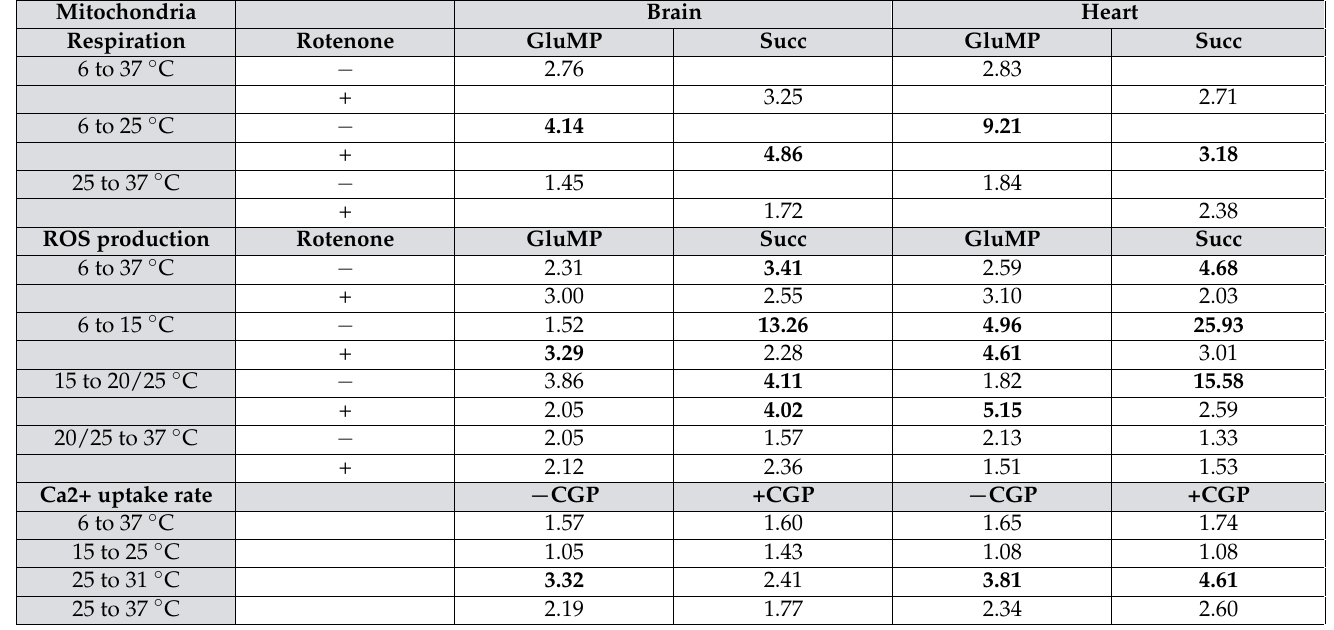
Table 1. Q 10 values calculated, for respiration, ROS production rate or Calcium uptake rate in mitochondria from brain and heart. Temperature range have been determined by segment between characteristic inflexion points in Arrhenius plots. For Ros production, the ranges of temperature were [15–25 ◦ C] and [25–37 ◦ C] for GluMP and [15–20 ◦ C] and [20–37 ◦ C] for Succ. The highest Q10 values are shown in